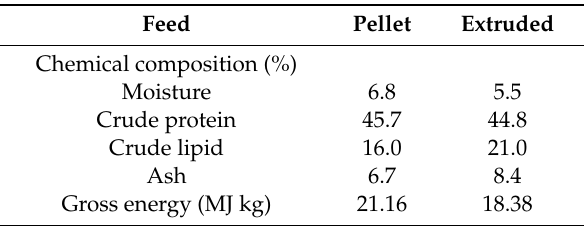
Table 1. Proximate composition of the feeds employed for the rainbow trout growing over the decade of water quality monitoring (2009–2019).